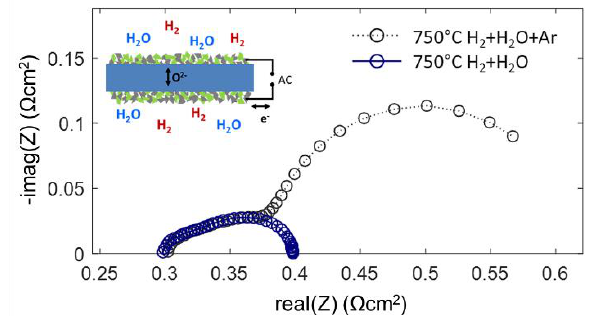
Figure 9. Impedance spectra of Ni-GDC anode cells (blue circles) in a pure H 2 + H 2 O atmosphere, and (grey circles) diluted H 2 + H 2 O in Ar balance. Both spectra overlap in the high-frequency regime and have the same electrolyte offset resistance.